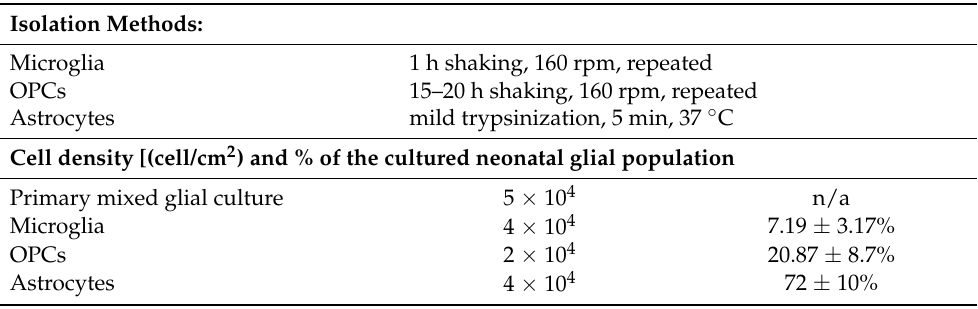
Table 2. Establishing the cultures of particular glial